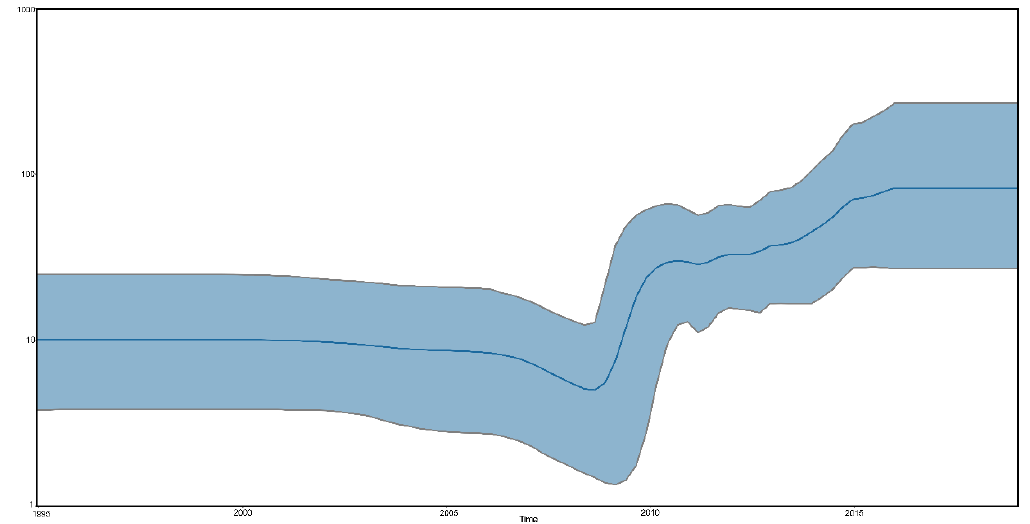
Figure 4. Bayesian skyline plot of the complete F gene of the sub-genotype VI.2.1.1.2.2 PPMV-1 strains. The dark blue line shows the mean value of genetic diversity, and the light blue shading shows the 95% confidence interval.